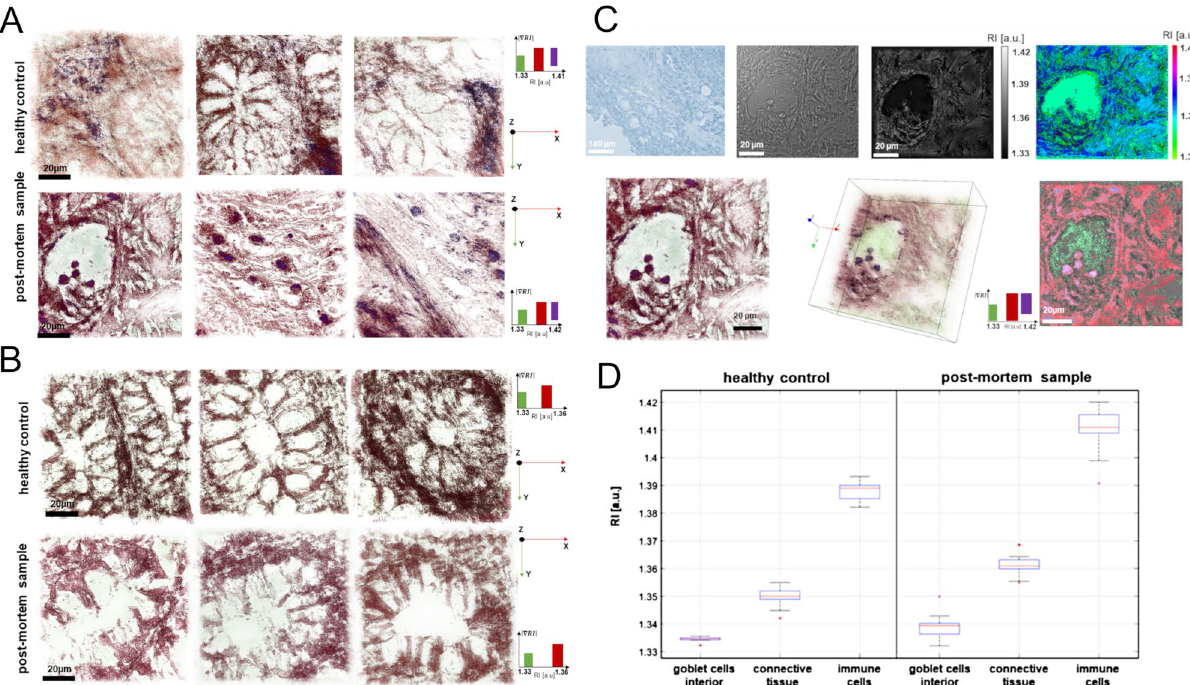
Figure 3. The representative results of the comparative analysis of the 3D-RI maps (upfront) of healthy control (n = 4) and post-mortem tissue samples (n = 4): ( A ) the cells with round and oval nuclei with a lymphocyte-like morphology present in the inter colonic glands and in the lumen of vessels and connective tissue, cell nuclei marked in violet; identified as immune cells ( B ) the goblet cells of colonic glands; ( C ), The schema of the RI data processing: (top row, first from the left) the microscopic image of the tissue sample, (top row, second from the left) the enlarged bright-field image of the region of interest, (top row, third from the left) reconstructed 2D-RI map, (top row, firs from the right) processed 2D-RI map, (bottom row, first from the right) digital staining of the tissue structures (green—an internal region of vessel lumen, red—connective tissue, violet—the nuclei of immune and endothelial cells), the digitally stained 3D-RI map of the tissue region (bottom row, center), the upfront of the digitally stained region of tissue area (bottom row, first from the left); ( D ) the boxplot representing the variations of the RI values of different tissue substructures (green—goblet cells interior, red— connective tissue, violet—immune